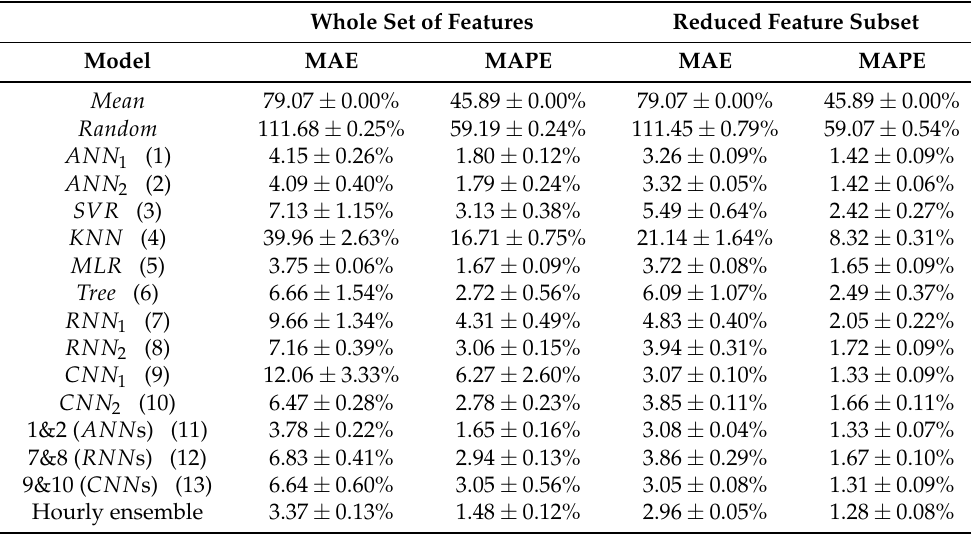
Table 2. Ausdata hour-ahead load forecasting